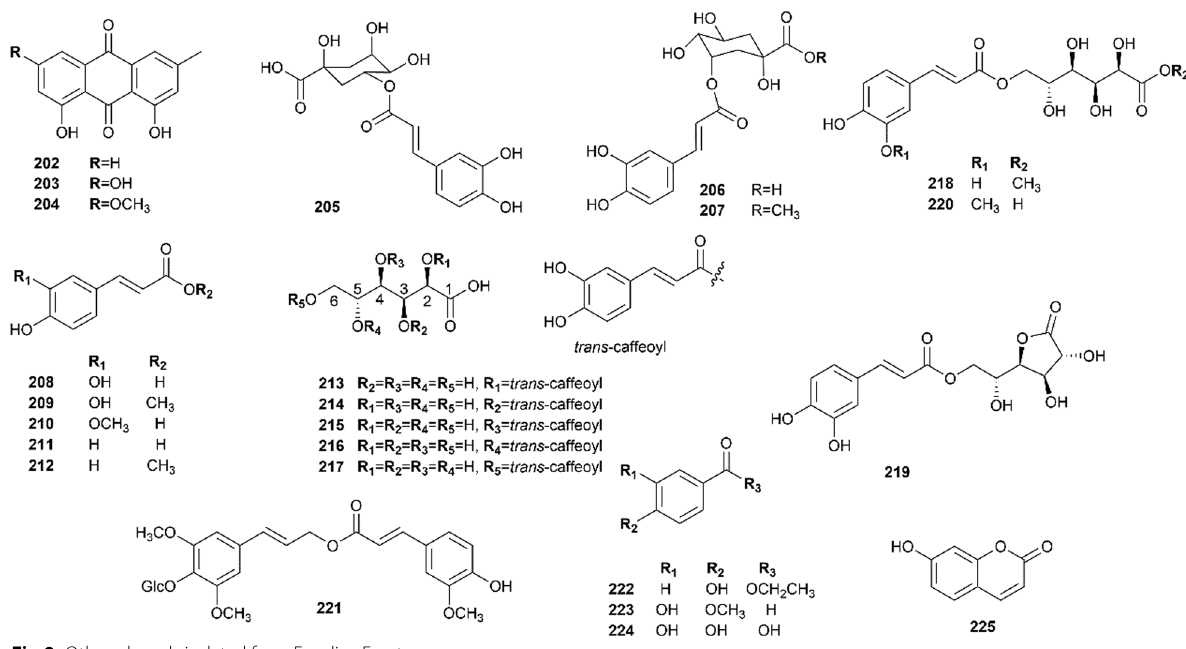
Fig.9 Other phenols isolated from Euodiae Fructus